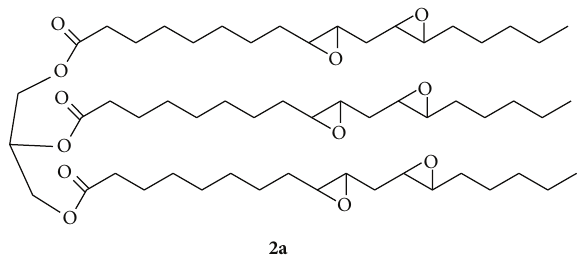
Figure 1: Structure of (Gly-LLL-ox 2a ): one of chemical species in ESBO (from linoleic in sn-1, sn-2, and sn-3).